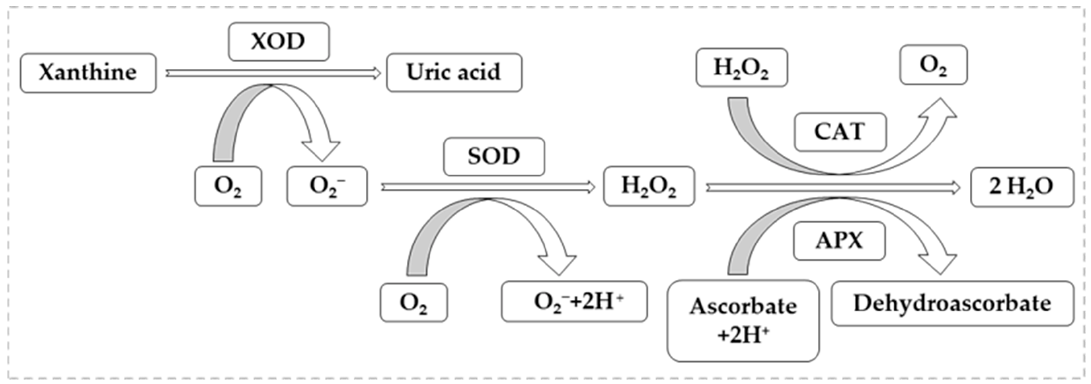
Figure 5. Main reactions of metalloenzymes involved in ROS metabolism in plant cells.